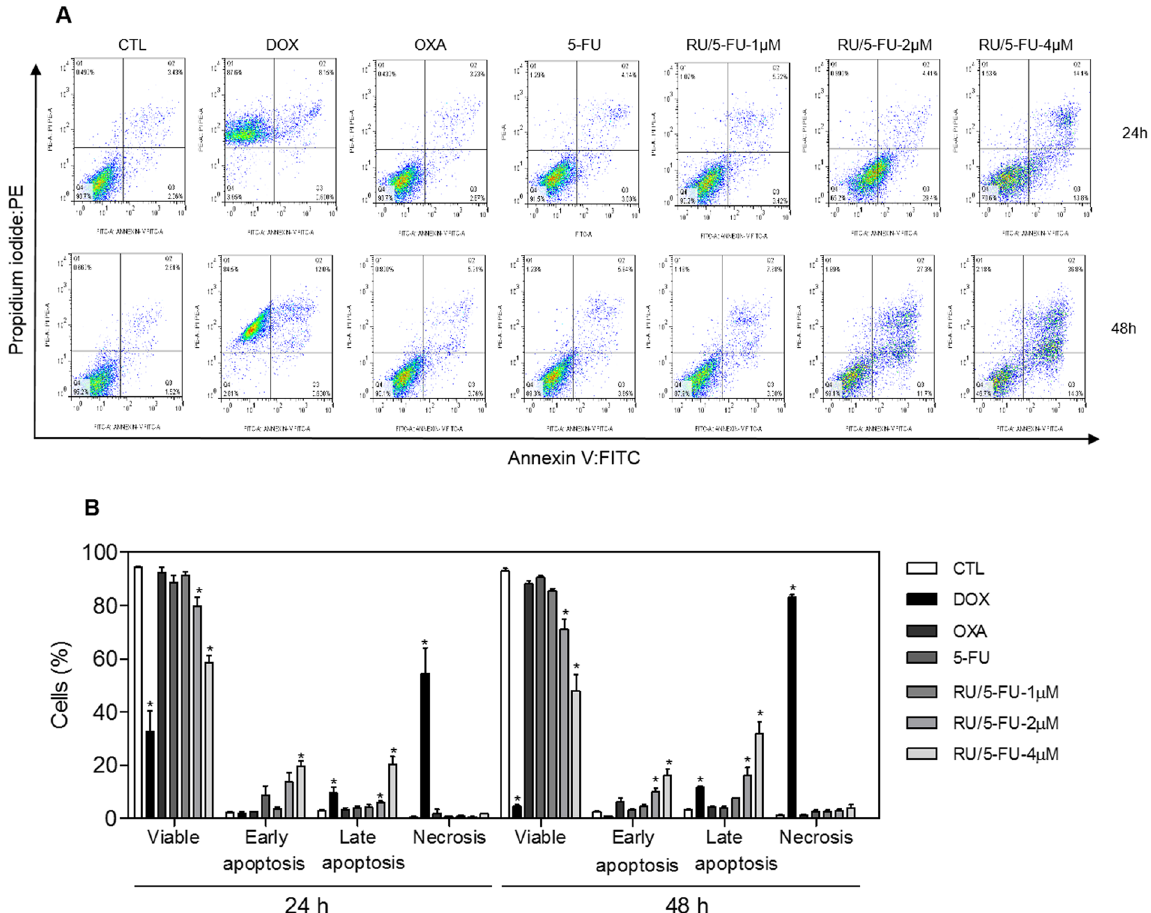
Figure 6. Effect of the complex [Ru(5-FU)(PPh 3 ) 2 (bipy)]PF 6 (RU/5-FU) in the apoptosis induction in HCT116 cells determined by flow cytometry using annexin V-FITC/PI staining 24 and 48 h after incubation. ( A ) Representative flow cytometry dot plots showing the percentage of cells in viable, early apoptotic, late apoptotic and necrotic stages. ( B ) Quantification of the cell viability. The negative control (CTL) was treated with the vehicle (0.1% DMSO) used for diluting the compound tested. Doxorubicin (DOX, 1 µ M), oxaliplatin (OXA, 2.5 µ M) and 5-fluorouracil (5-FU, 4 µ M) were used as the positive controls. Data are presented as the mean ± S.E.M. of three independent experiments performed in duplicate. Ten thousand events were evaluated per experiment and cellular debris was omitted from the analysis. * p < 0.05 compared with the negative control by ANOVA followed by Student Newman-Keuls